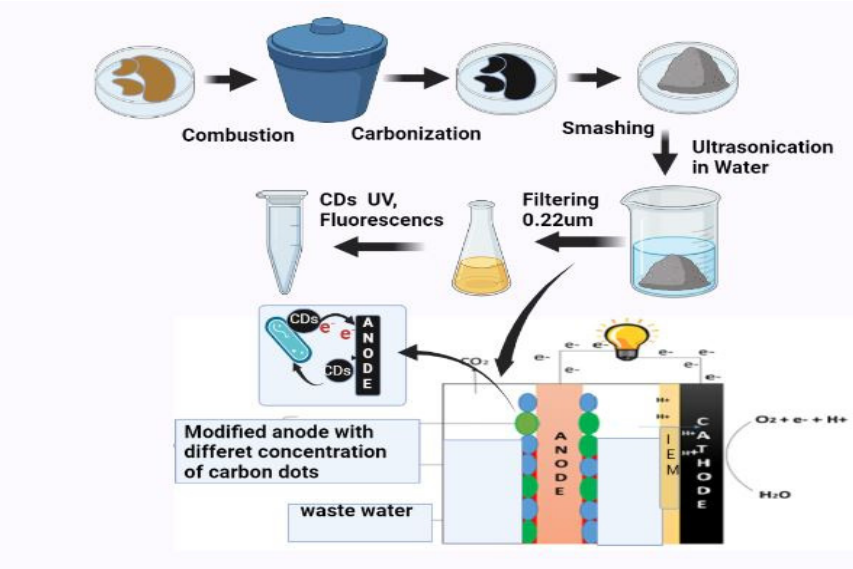
Figure 8. Schematic representataion of CDs synthesis and MFCs used in the